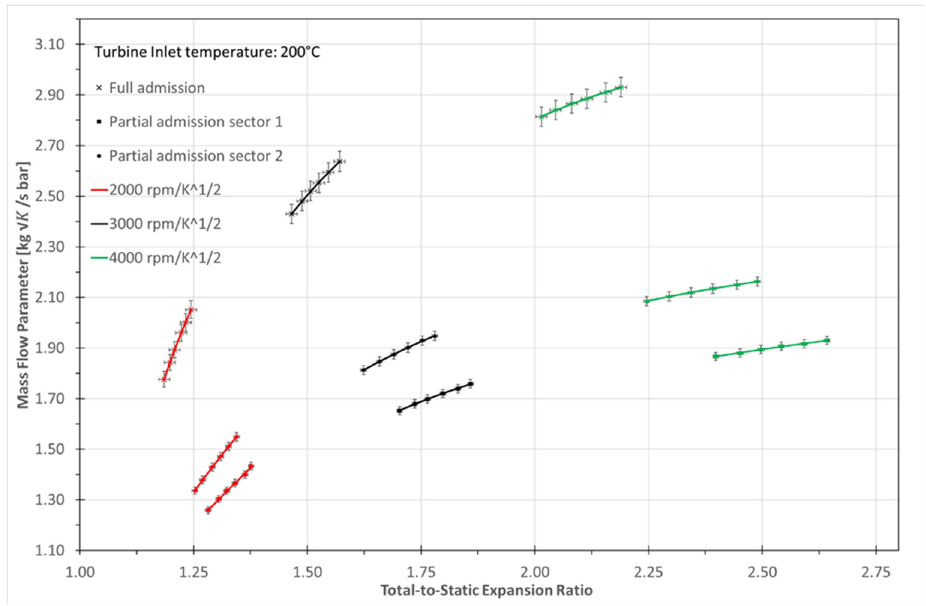
Figure 4. Full and partial admission conditions.